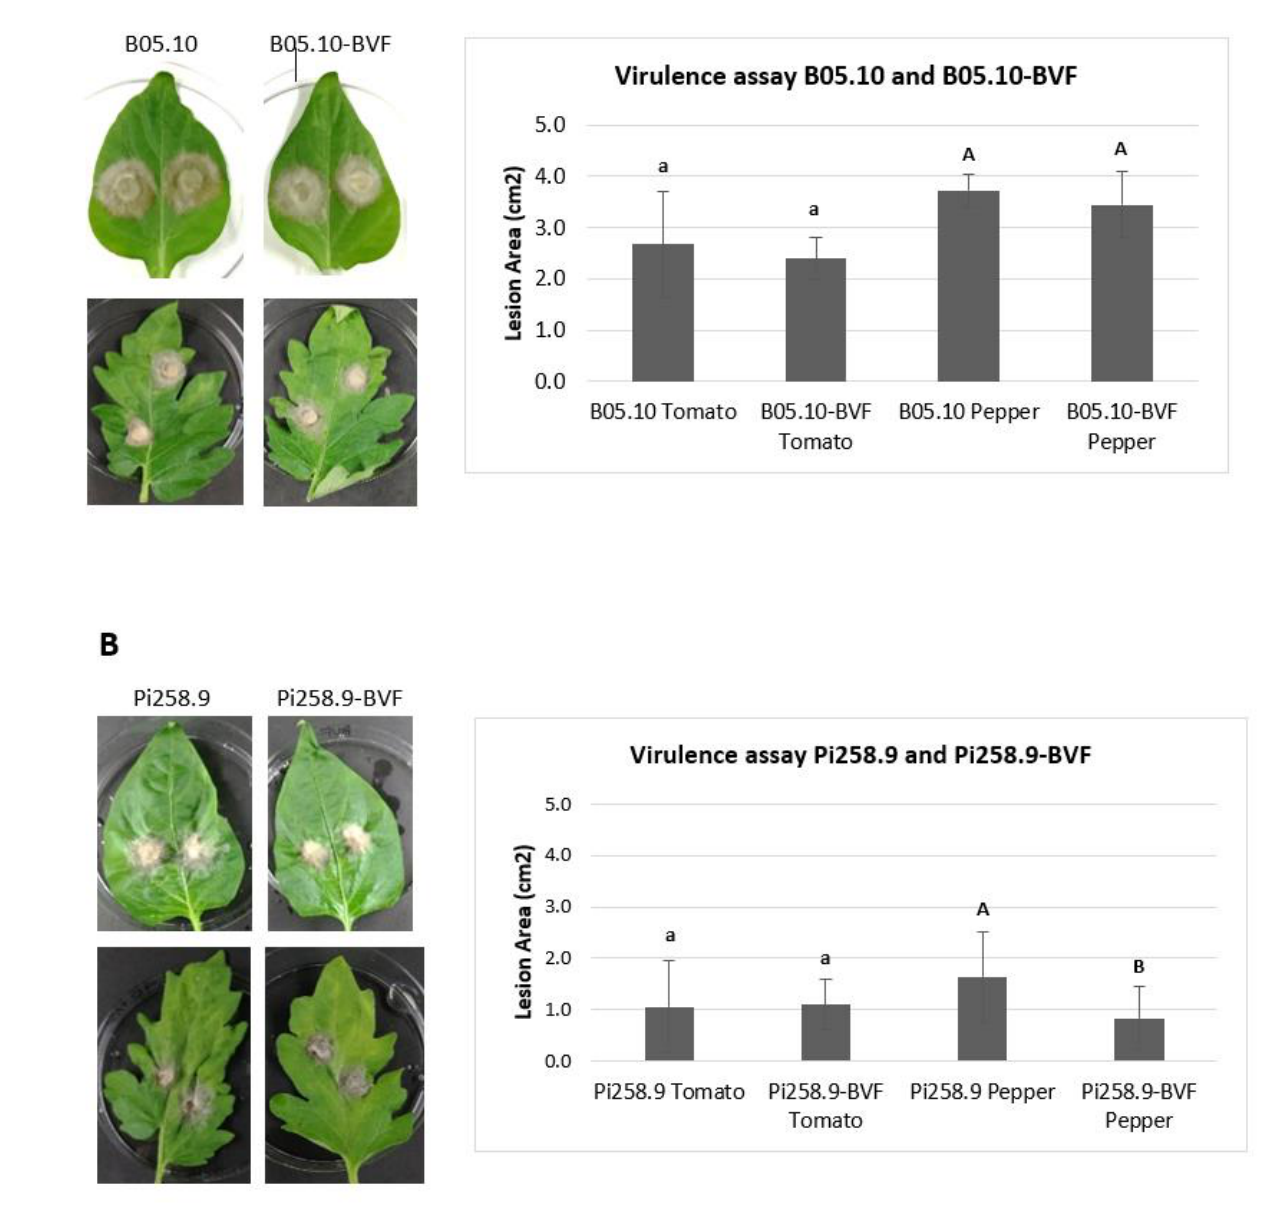
Figure 6. Virulence of virus-free and BVF-488–transfected B. cinerea isolates B05.10 and Pi258.9. Comparison of mean lesion area (cm 2 ) at 72 h after inoculation with mycelial agar plugs on detached tomato (four replicates) leaves and pepper (seven replicates) leaves of ( A ) B05.10 and ( B ) Pi258.9 strains.